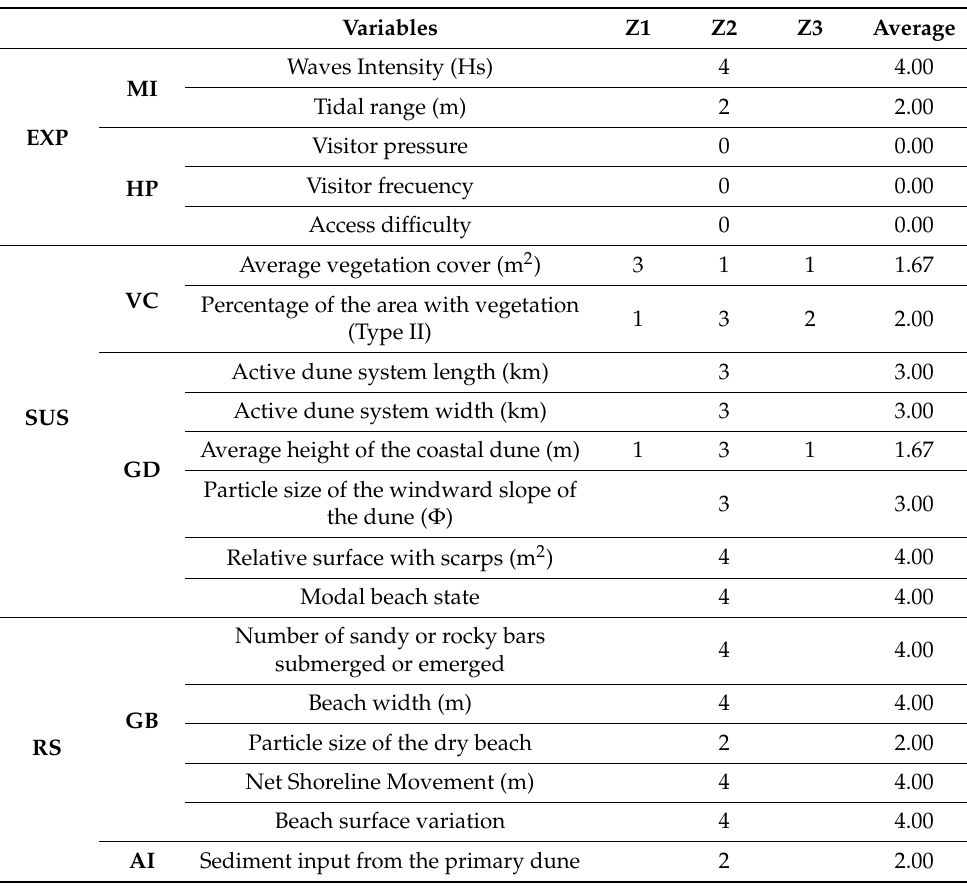
Table 2. Values assigned to each variable according to the results obtained in the analysis (Section 3.1) for each of the three areas considered (Z1, Z2 and Z3). Legend: MI: marine influence; HP: human pressure; VC: vegetation cover; GD: geomorphology of the dune system; GB: geomorphology of the beach; AI: aeolian influence; EXP: exposure; SUS: Susceptibility; RS: